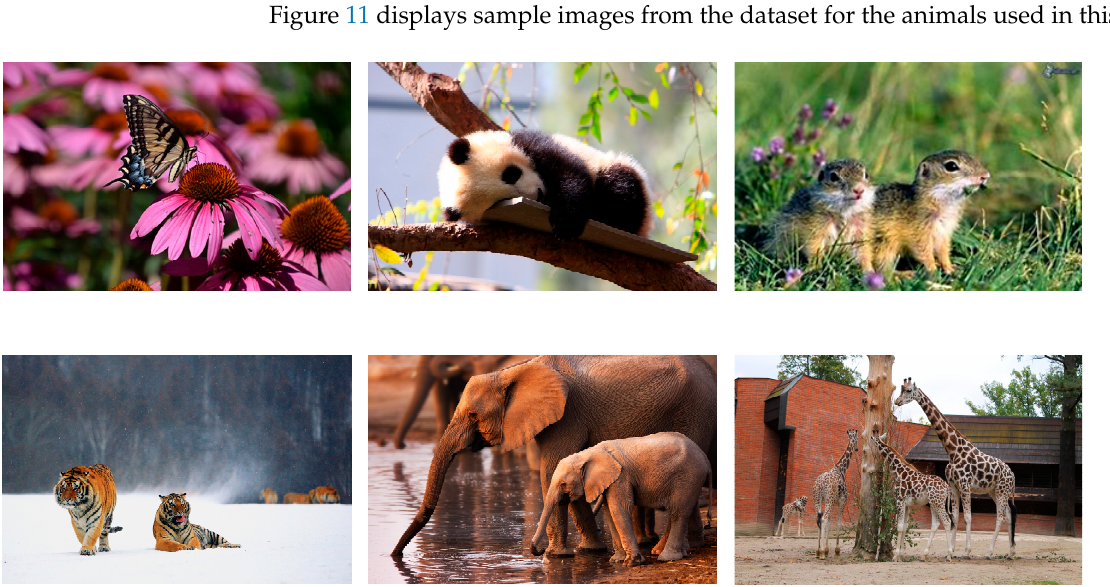
Figure 11. Example of the animal dataset.